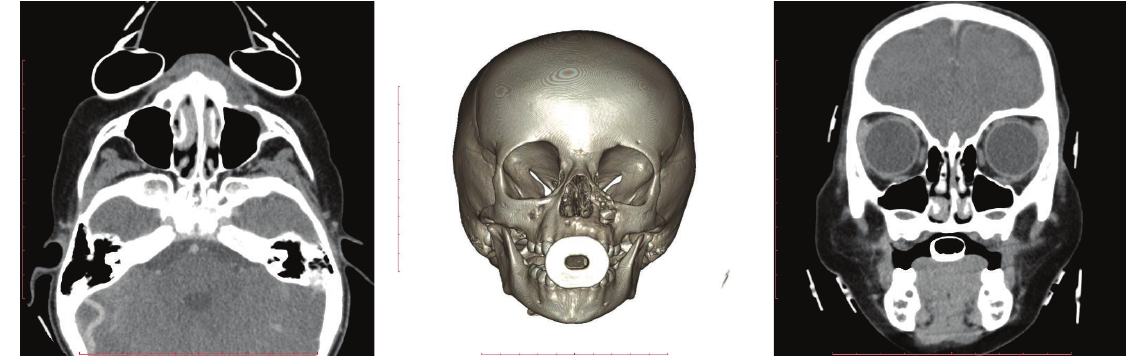
Figure 6: Coronal, axial, and 3D bone reconstruction showing no recurrence of the maxillary